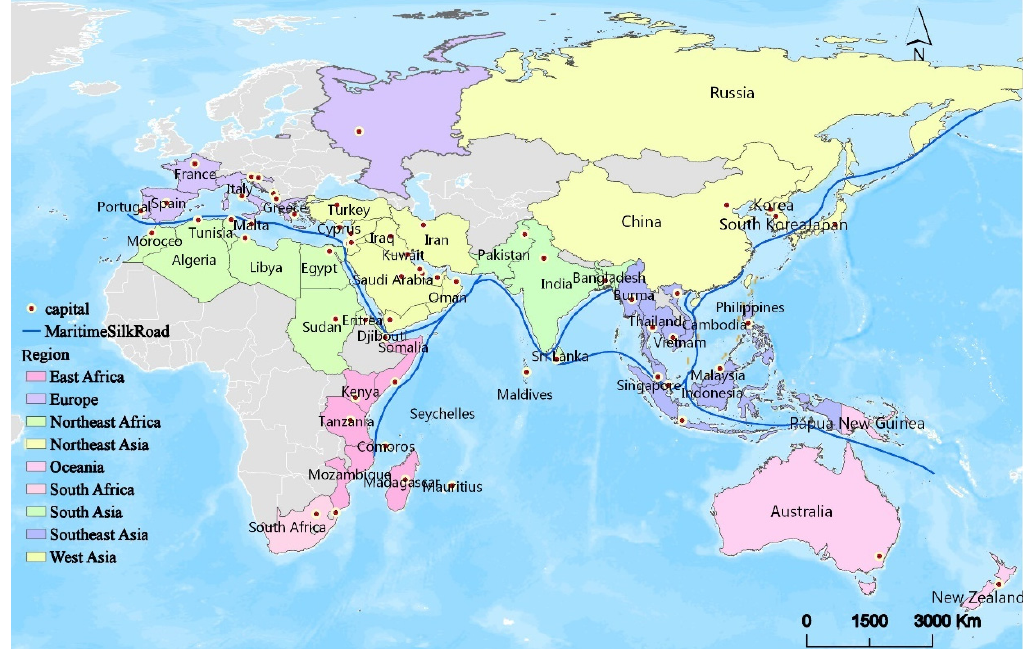
Figure 1. Study area routes (given in blue lines) and Maritime Silk Road countries. The study area consist of 9 regions.